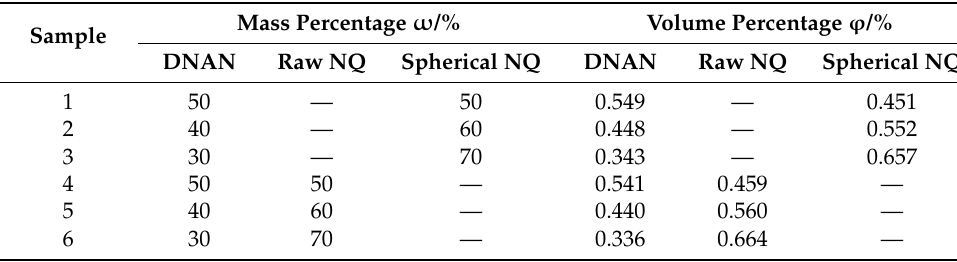
Table 2. Multiphase proportion of the materials used in the